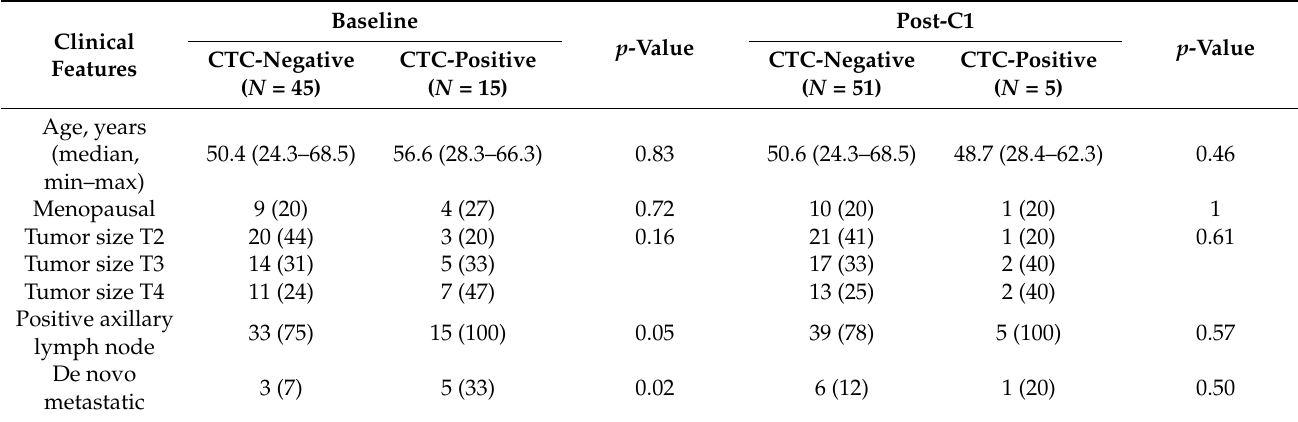
Table 1. Correlation between circulating tumor cells (CTC) and demographics features. Data are expressed as N (%) unless otherwise specified.